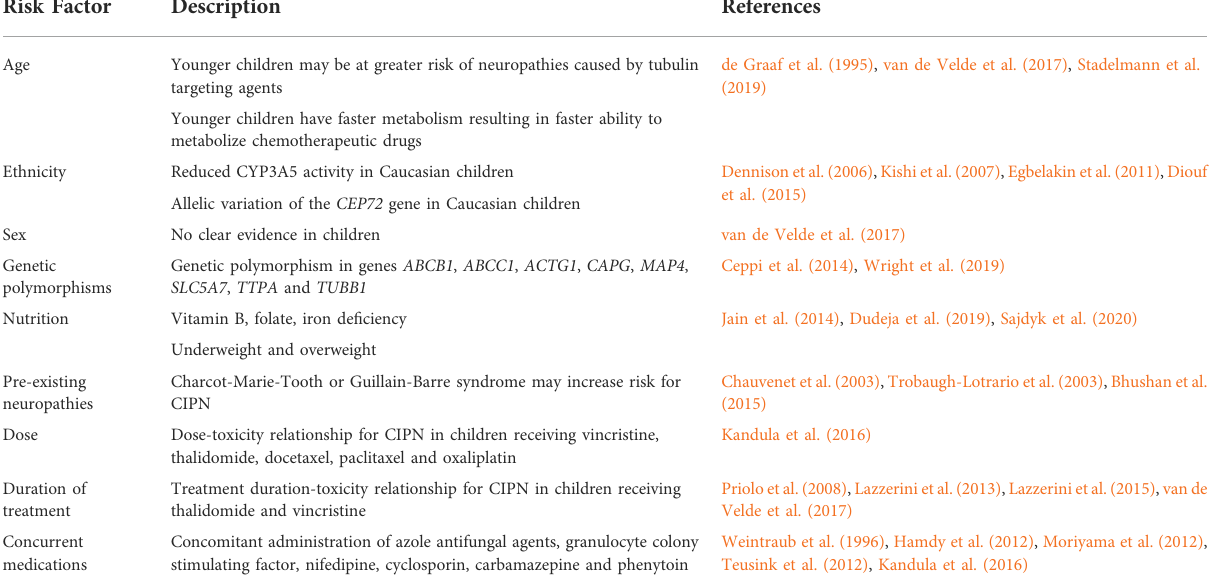
TABLE 5 Risk factors associated with pediatric chemotherapy-induced peripheral